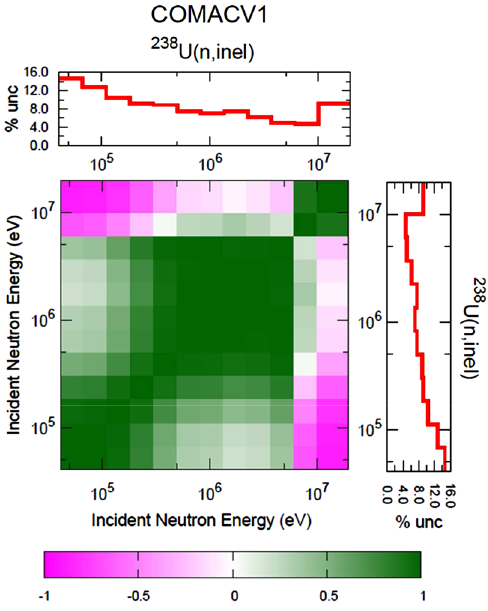
Fig. 5. 238 U inelastic uncertainty and energy correlation: COMACV1.